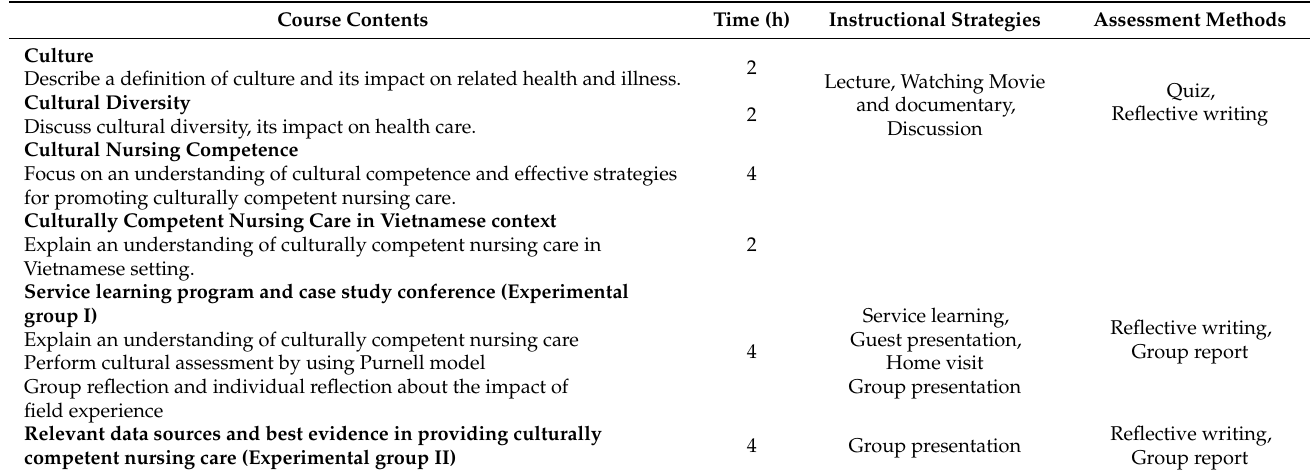
Table 1. Cultural contents for educational